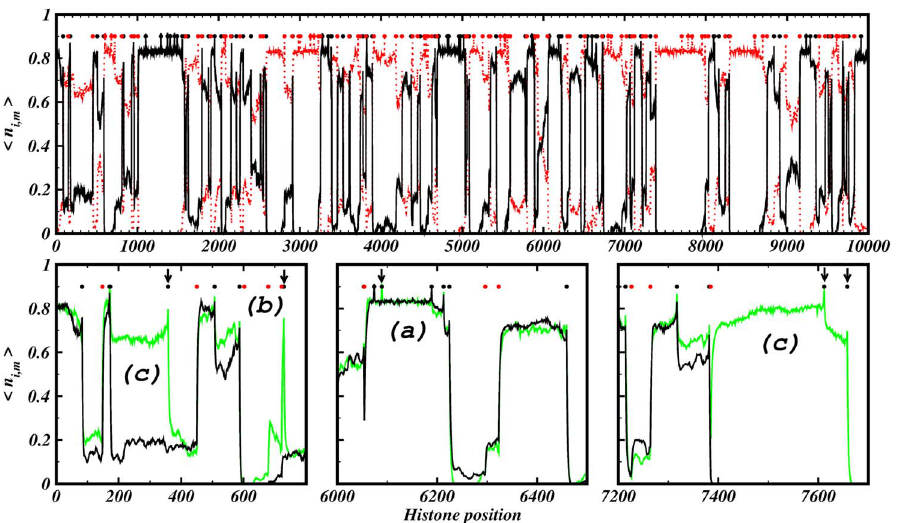
Figure 9. New nucleation sites can lead to different effects. Upper panel: Black and red lines denote the spatial distribution of histone mark 1 and 2, respectively. The 90 (100) nucleation sites for mark 1 (2) are shown as black (red) points. Lower panels: Zooms on the spatial distribution of mark 1 for 90 nucleation sites (black line) and 100 nucleation sites (green line). The 100 nucleation sites of mark 2 remain unchanged. The arrows tag new inserted nucleation sites of mark 1. Three different nucleation effects can be observed: (a) no change ; (b) narrow spike around nucleation site ; (c) activation of large region. The simulation parameters were p s ,2 ~ p s ,1 ~ 0 : 1 , p d ~ 0 : 02 and p a ~ 0 : 1 .